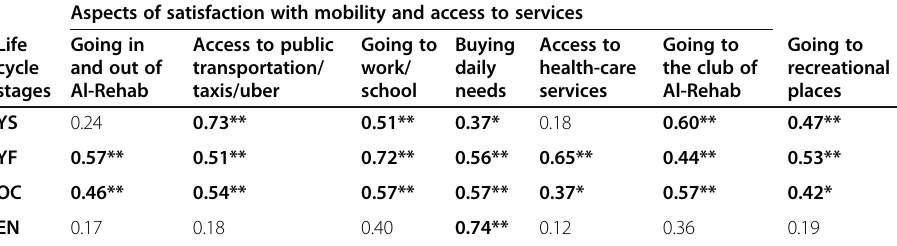
Table 11 Correlations between satisfaction with mobility and access to services and its different aspects Aspects of satisfaction with mobility and access to services